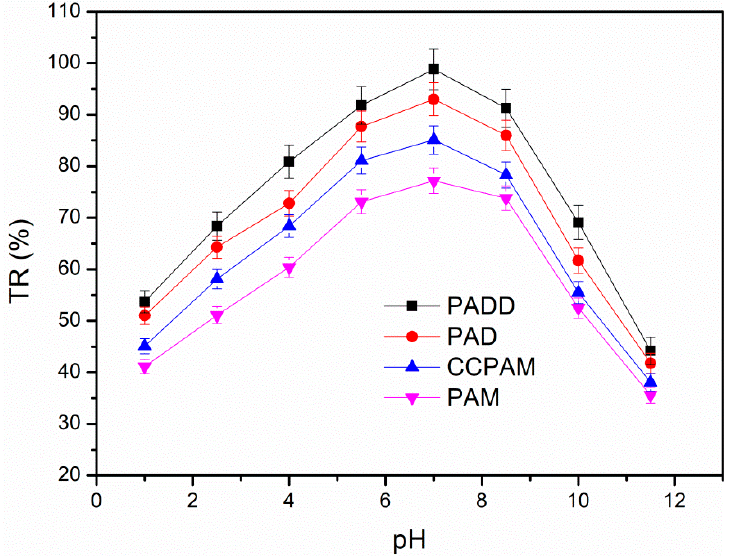
Figure 7. The influence of pH on turbidity removal rate (TR).